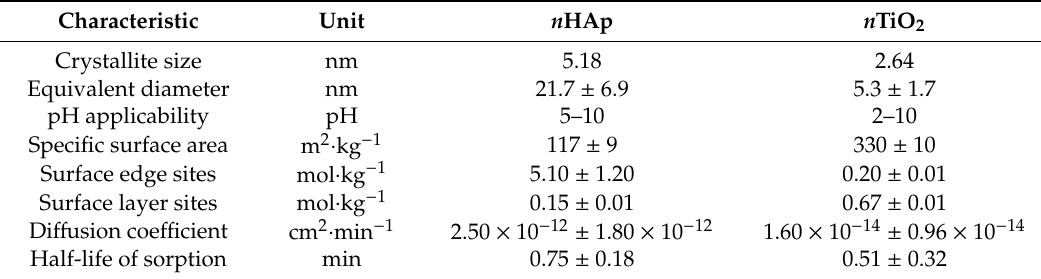
Table 1. Characteristics of n HAp and n TiO 2